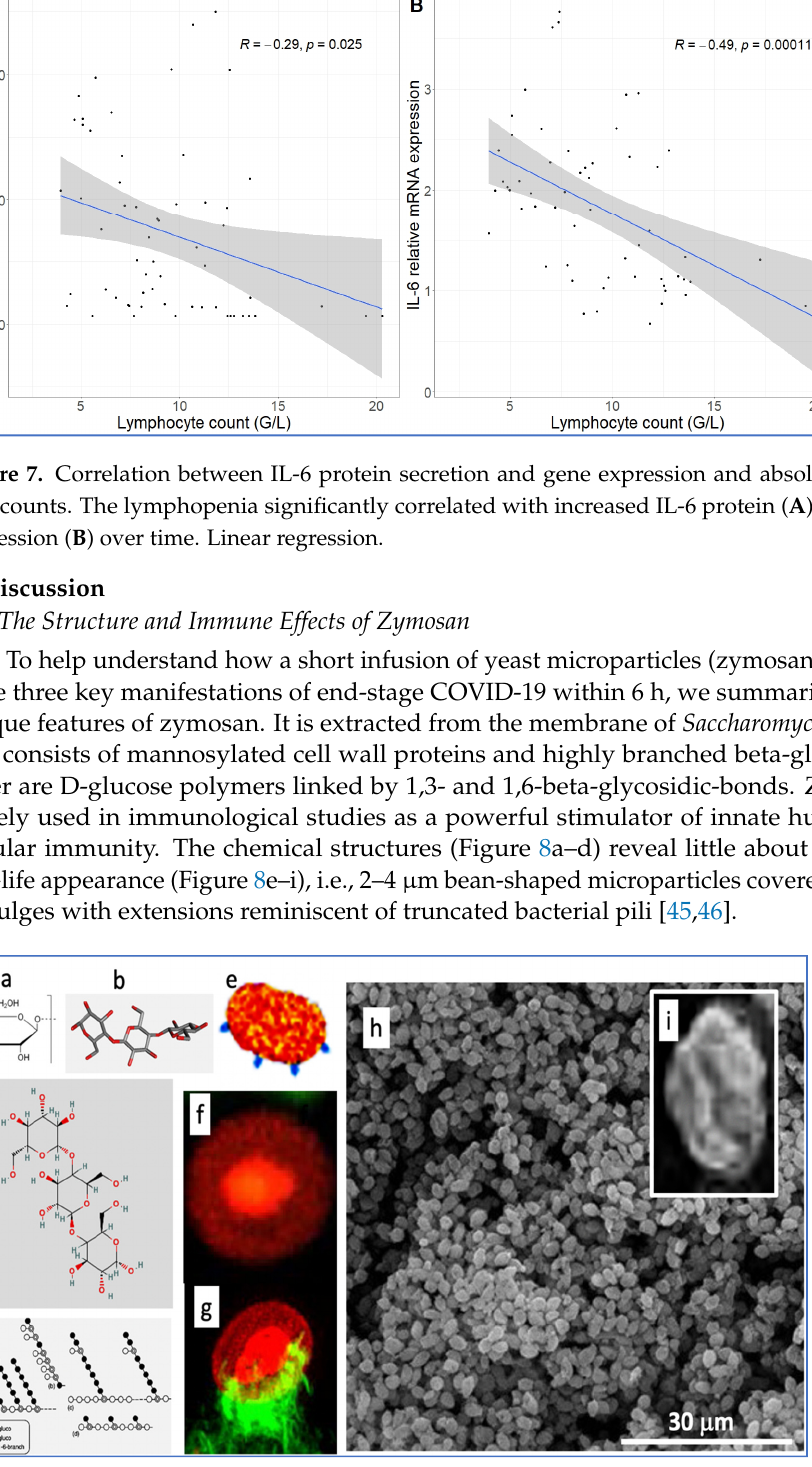
Figure 6. Relationship between serum cytokine levels and NLR. The NLR (neutrophil granulocyte- to-lymphocyte ratio (blue line) increased continuously in an hour after zymosan administration, which was preceded by increased TNF-alpha ( A ) and IL-6 ( B , C ). The expression of CCL2 ( D ), IL-